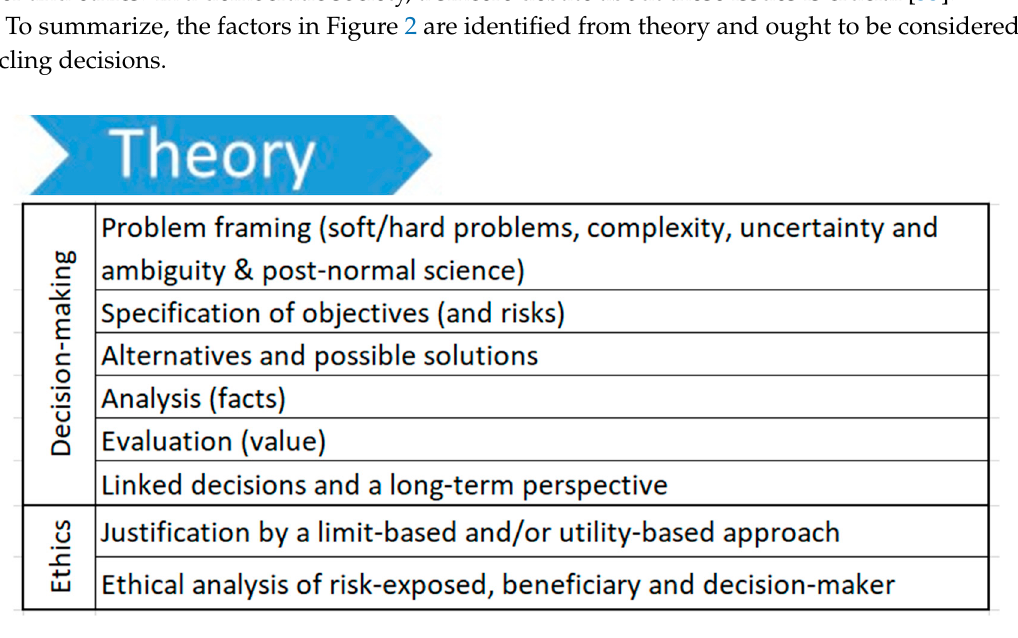
Figure 2. Identified factors from theory that impact recycling decisions.